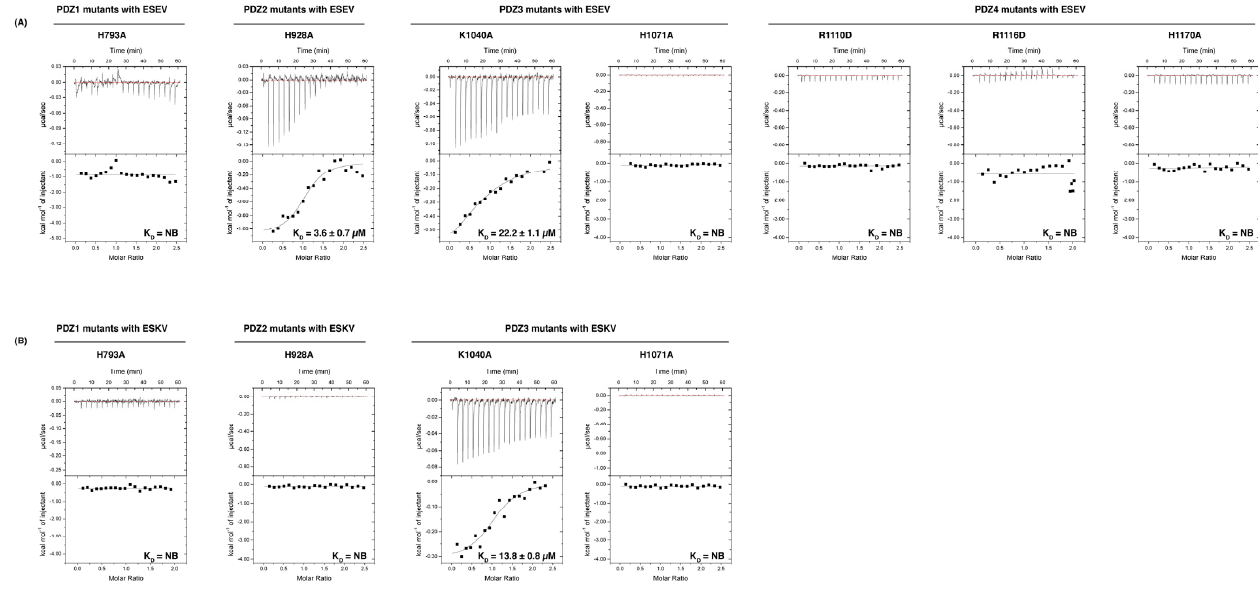
Figure 5. Binding profiles of mutant SCRIB PDZ domain interactions with NS1 PBM peptides. Isolated mutant SCRIB PDZ domain interactions with ( A ) NS1 ESEV PBM peptides or ( B ) NS1 ESKV PBM peptides. Each profile is represented by a raw thermogram, and a binding isotherm fitted with a one-site binding model (bottom panels). K D : dissociation constant (in μ M); ±: standard deviation (SD); NB: no binding. Each of the values was calculated from at least three independent experiments.